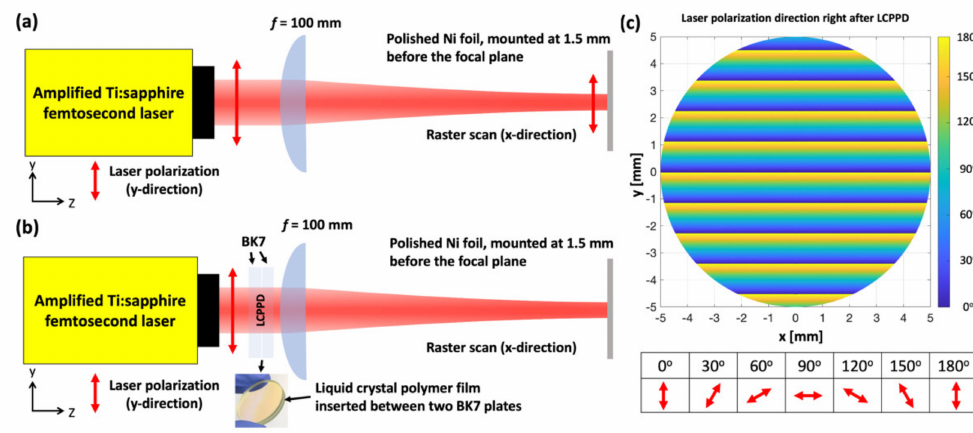
Figure 1. ( a ) Schematic of UD-LSFL fabrication in our experiments. The polarization direction of the fs laser pulses is in the y -direction. ( b ) Schematic of OD-LSFL fabrication in our experiments. The polarization direction of the fs laser pulses is manipulated by our liquid crystal polymer patterned depolarizer (LCPPD). ( c ) Calculated directions of polarization within the 1/e 2 intensity radius of the fs laser pulses right after LCPPD. Angles denote the rotated angles of polarization direction due to LCPPD with respect to the y -direction.